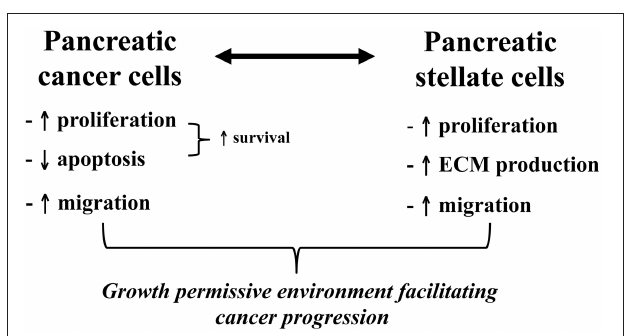
FIGURE 6 | Bidirectional interactions between pancreatic cancer cells and PSCs. The diagram outlines the effects of pancreatic cancer cells on PSCs and vice versa. The observed interaction between these two cell types facilitates local tumour growth as well as regional and distant metastasis of pancreatic